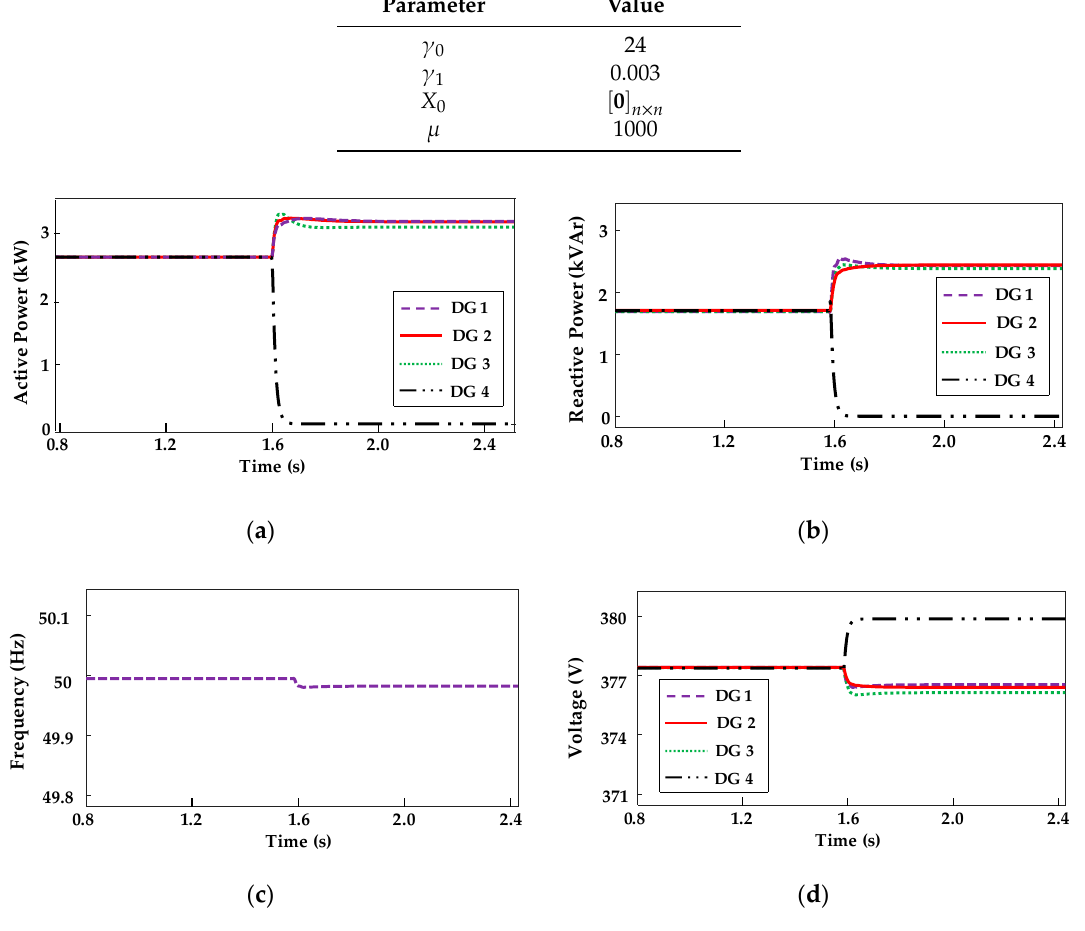
Figure 6. Scenario with proposed MSMC controller: ( a ) active power sharing; ( b ) reactive power sharing; ( c ) system frequency; ( d ) DGs terminal voltages.